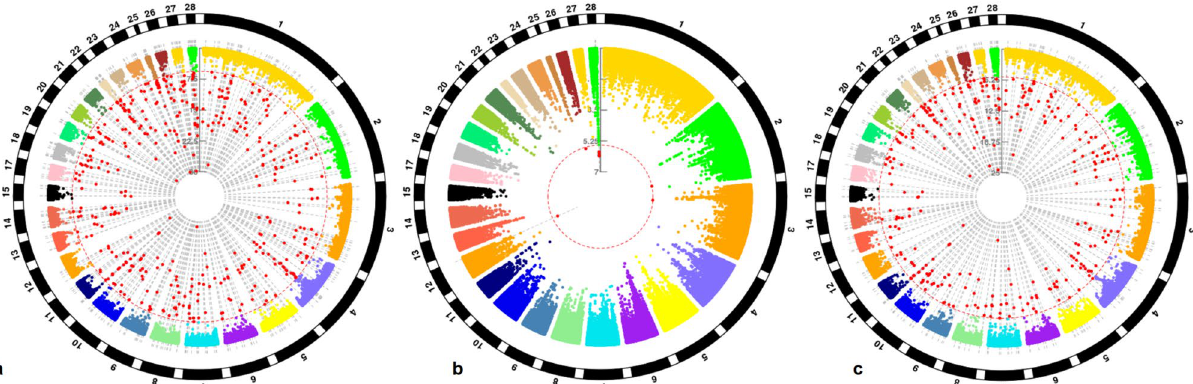
Figure 1. Circular Manhattan plots showing the − log 10 (p values) of SNPs across the 28 autosomal chromosomes for body weight (BW) ( a ), egg number (EN) ( b ) and both traits ( c ), respectively. Red dots in Manhattan plots denote the genome-wide significant SNPs. Plots were constructed using the CMplot package (https:// github. com/ YinLi Lin/R- CMplot) in R (http:// www.r- proje ct.